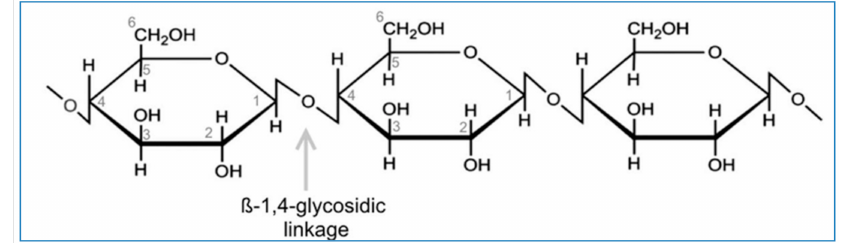
Figure 1. Schematic representation of β 1,4 glycoside linkage in glucose units. Forms of Cellulose and its derivatives: Cellulose existence has both cellulose I (greenly plants) and cellulose II (lower phyla or bacterial or algal species) as allomorphs the orien- tation of the AGU units are either antiparallel or parallel respectively [8,9]. Allomorphic forms of cellulose are I, II, IIII, IIIII, IVI, IVII. These forms exhibit difference in structures such as cell dimensions, intra/inter hydrogen bonding among cells and cellulose adjacent polarity [10]. Cellulose I resemble nanofibrils since the glucose units are parallel arranged. (Figure 2) Indicated that natural cellulose in crystalline form I has two sub allomorphs, α and β , that are single chain and in triclinic or monoclinic unit